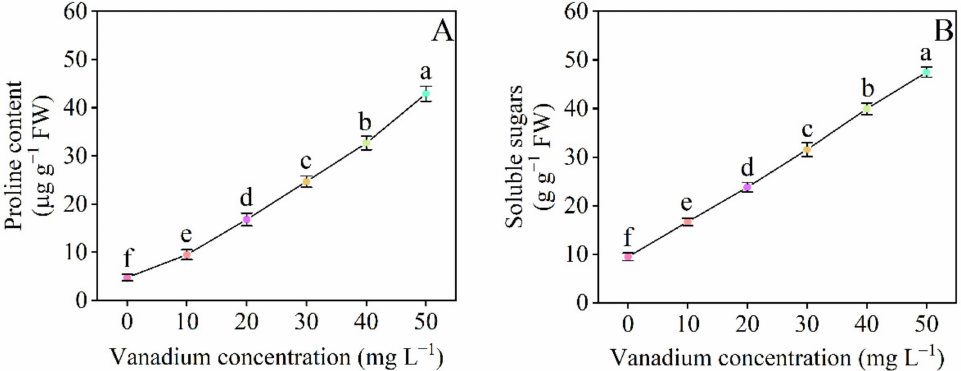
Figure 7. Effect of vanadium on proline ( A ) and soluble sugars ( B ) content in pepper seedlings. Means ± SE, n = 4, significant differences are exhibited by lowercase letters (at p < 0.05), according to Fisher’s least significant difference test.